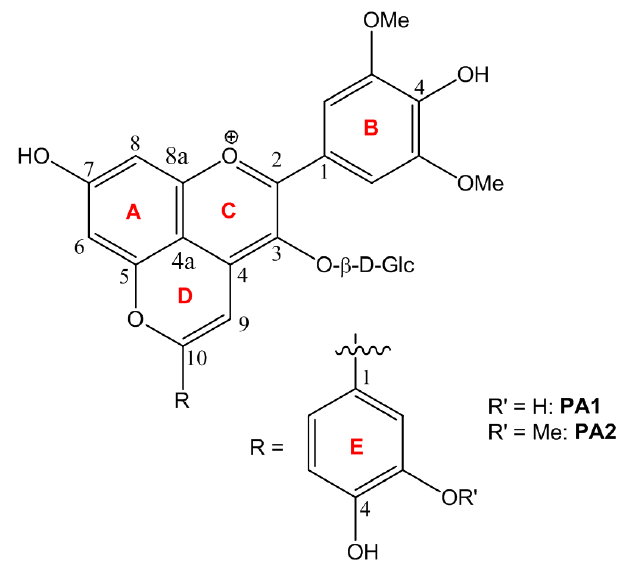
Figure 1. Structures of pyranomalvidins pigments catechyl-pyranomalvidin-3- O -glucoside (PA1) and guaiacyl-pyranomalvidin-3- O -glucoside (PA2). Controversial results have been reported on the physicochemical properties of pyranoanthocyanins. Quijada-Morín et al. [9] investigated the physicochemical and chromatic features of PA1 and PA2 in the pH range 2.0–4.5. A correct curve-fitting of the visible absorbance vs.